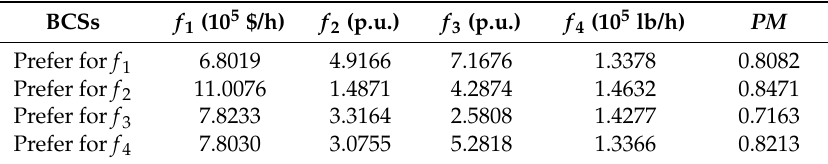
Table 7. BCSs of the Hebei provincial power system.